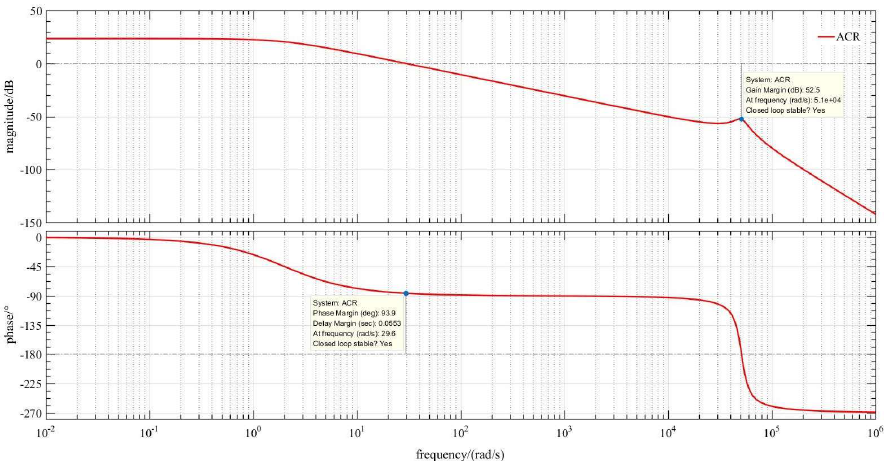
Figure 9. Bode diagram of ACR control system.